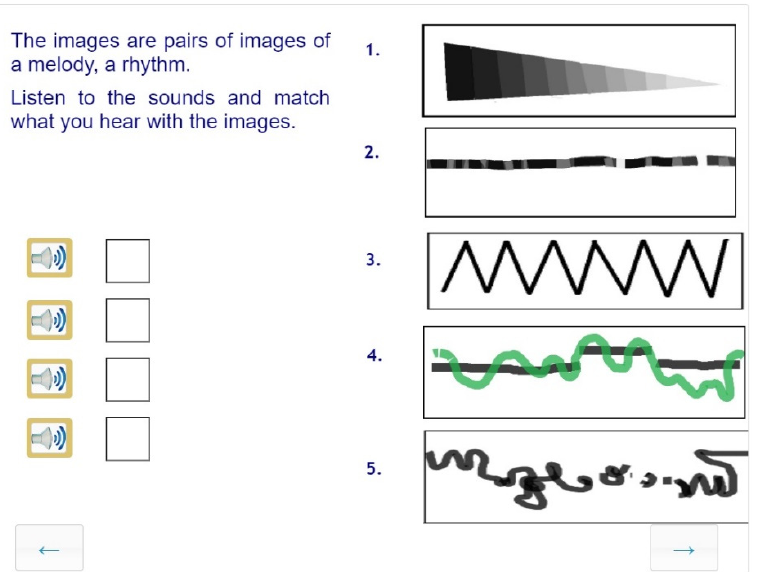
Figure 10. Sample task for modality shift: a task designed to interpret the visual and auditory modality. This anchor item was solved in all three grades.